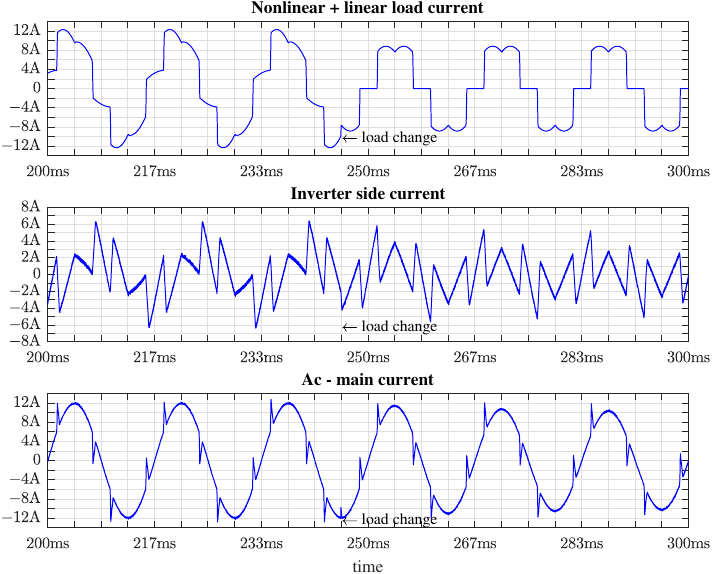
Figure 11. Main waveforms in power converter: from top to bottom, nonlinear + linear load current, inverter side current (compensation current), ac-main current (compensated